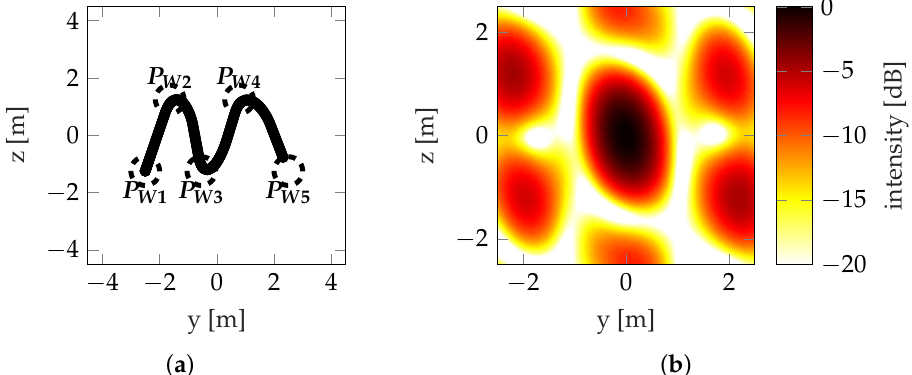
Figure 14. Worst initial situation—run #5: ( a ) Trajectory with waypoints denoted by P W and the acceptance circles marked with a dotted line. ( b ) PSF.